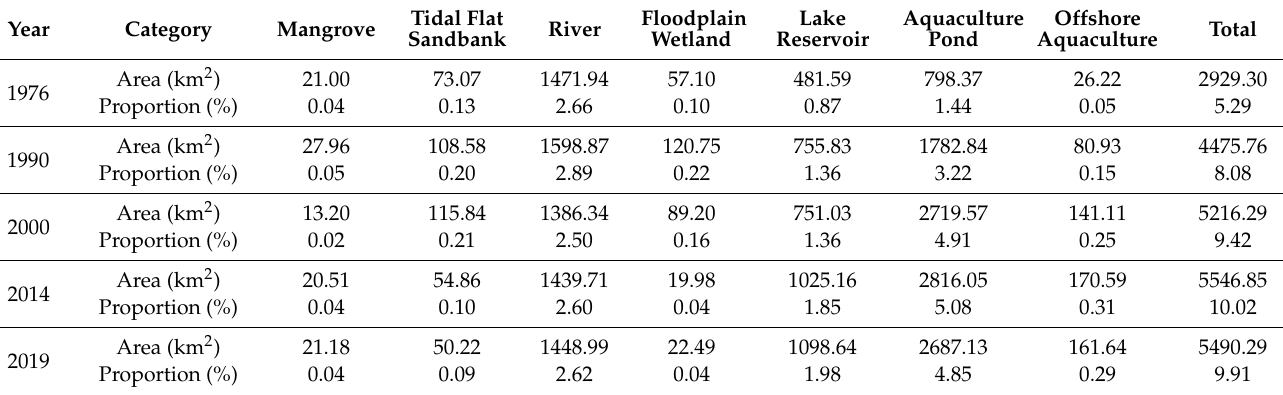
Table 5. Area of each wetland type and the proportion of total area of the region.